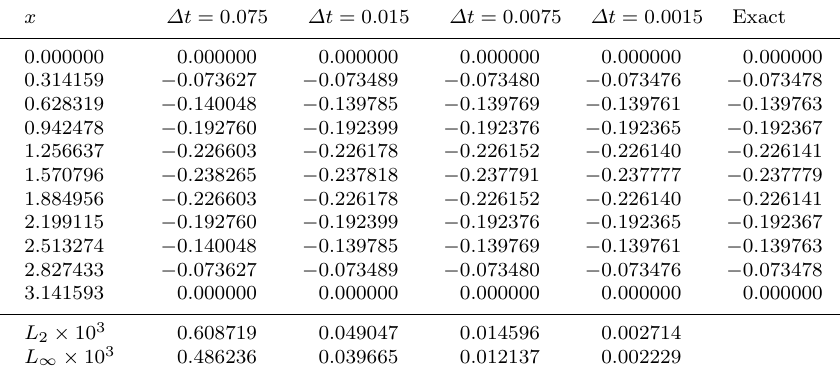
Table 7. The comparison of solutions and error norms of the diffusion-wave problem for γ = 1 . 5, M = 40 and t f = 3 . 75. x ∆t = 0 . 075 ∆t = 0 . 015 ∆t = 0 . 0075 ∆t = 0 . 0015 Exact 0.000000